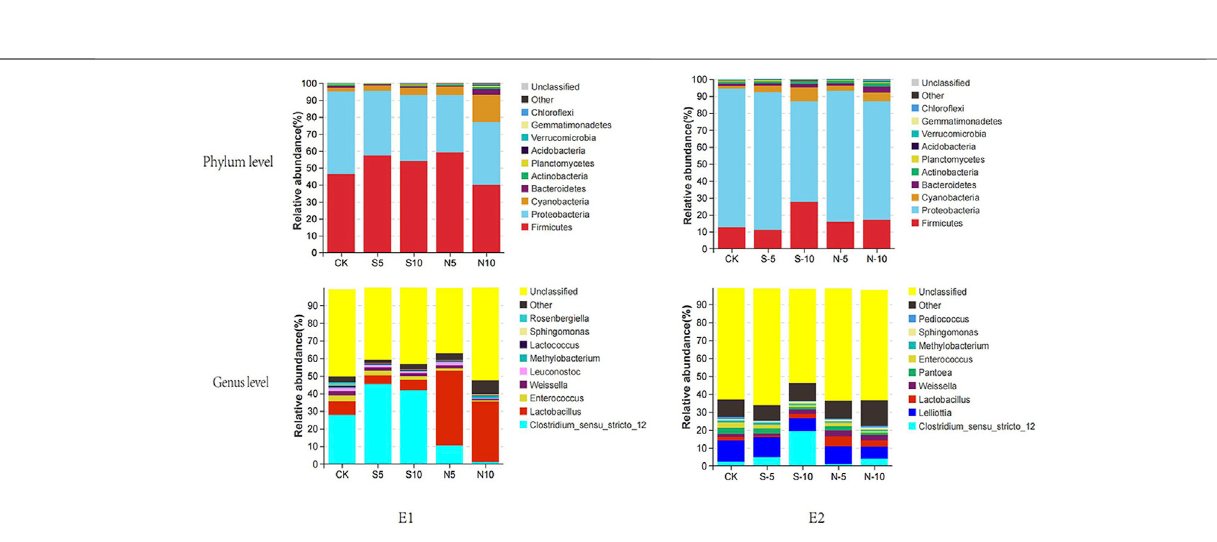
Frontiers in Environmental Science |